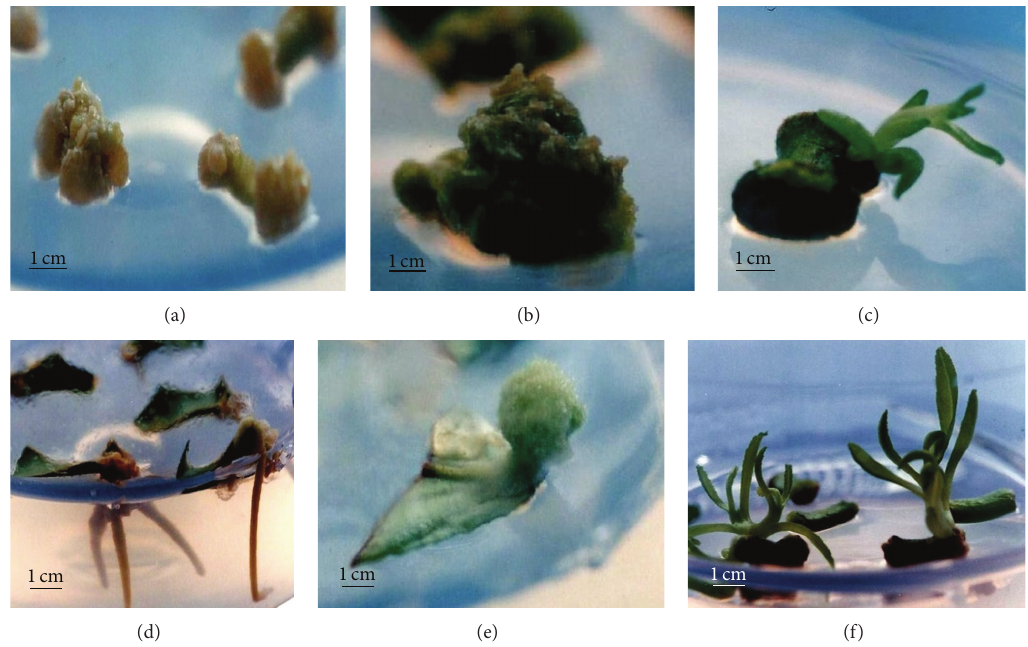
Figure 1: Various explants cultured on optimum regeneration media (MS media supplemented with 1.5 mgL −1 NAA and 2.0 mgL −1 BAP), maintained under 16 hours of light and 8 hours of darkness, with light intensity of 1000 lux. (a) Formation of yellow callus from root explant, (b) formation of green callus from root explant, (c) formation of green callus and production of shoot primordia from stem explant, (d) formation of roots from leaf explant after 18 days of culture, (e) formation of green callus from leaf explant, and (f) formation of multiple shoots from stem